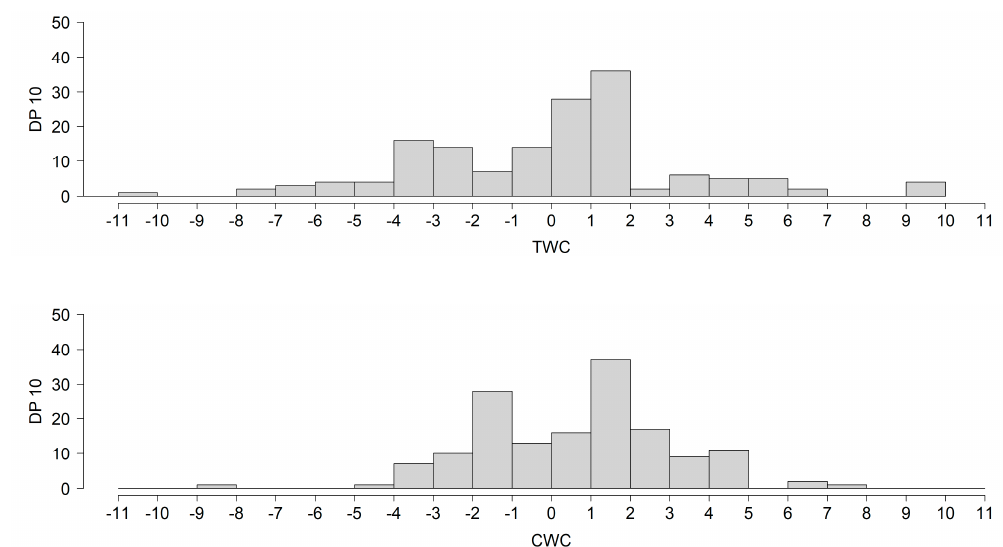
Figure 5. Detection positive ten minutes (DP10) of bat recordings in relation to the tailwind and crosswind components, assuming a WSW migration direction. Positive TWC = tailwinds; negative TWC = headwinds. Positive CWC = offshore wind; negative CWC = onshore wind.